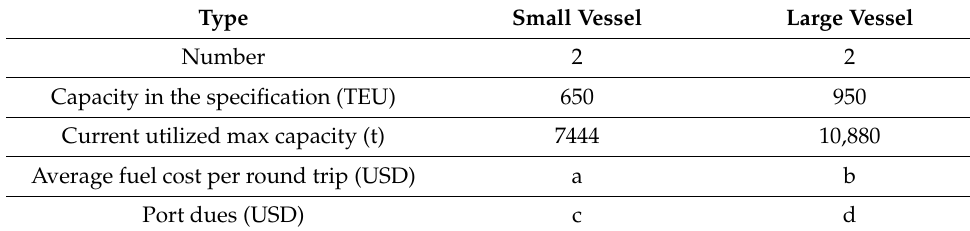
Table 4. Vessel information.